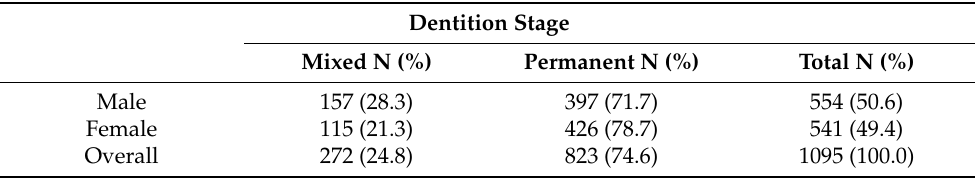
Table 4. Distribution of dentition stage between genders in 12-year-olds (excluding 7 subjects of unknown